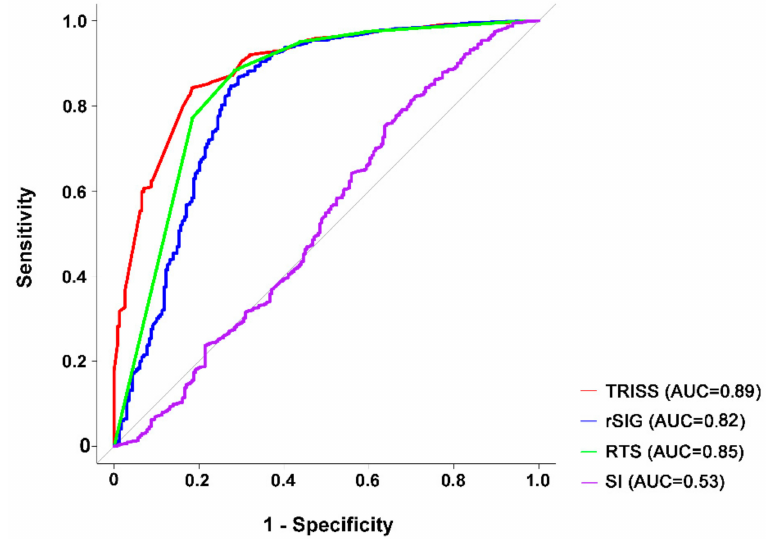
Figure 2. Area under the curve (AUC) of TRISS, rSIG, RTS, and SI in predicting the mortality of patients with isolated head